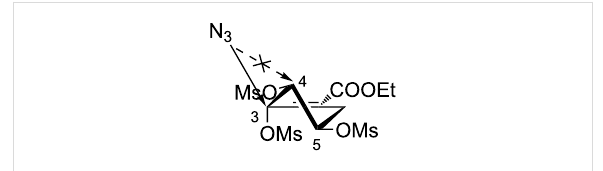
Figure 6: Regio- and stereospecific nucleophilic -N 3 group